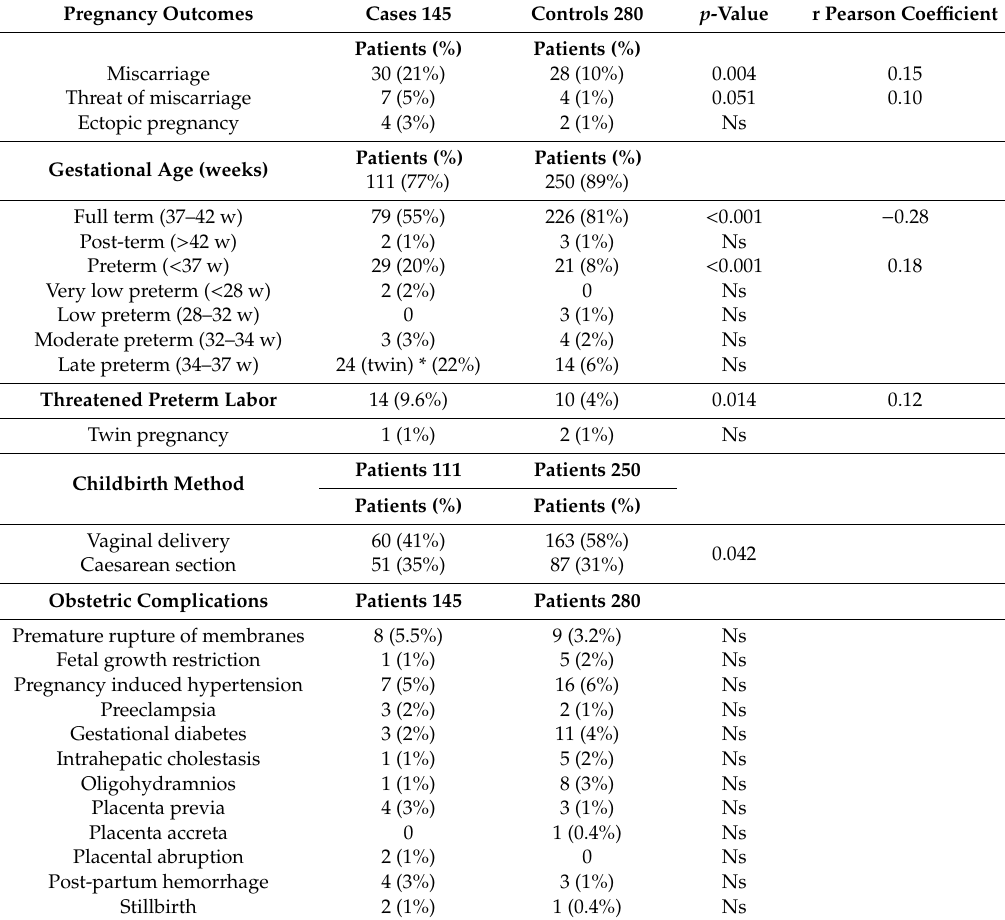
Table 3. Pregnancy outcomes in women with endometriosis and